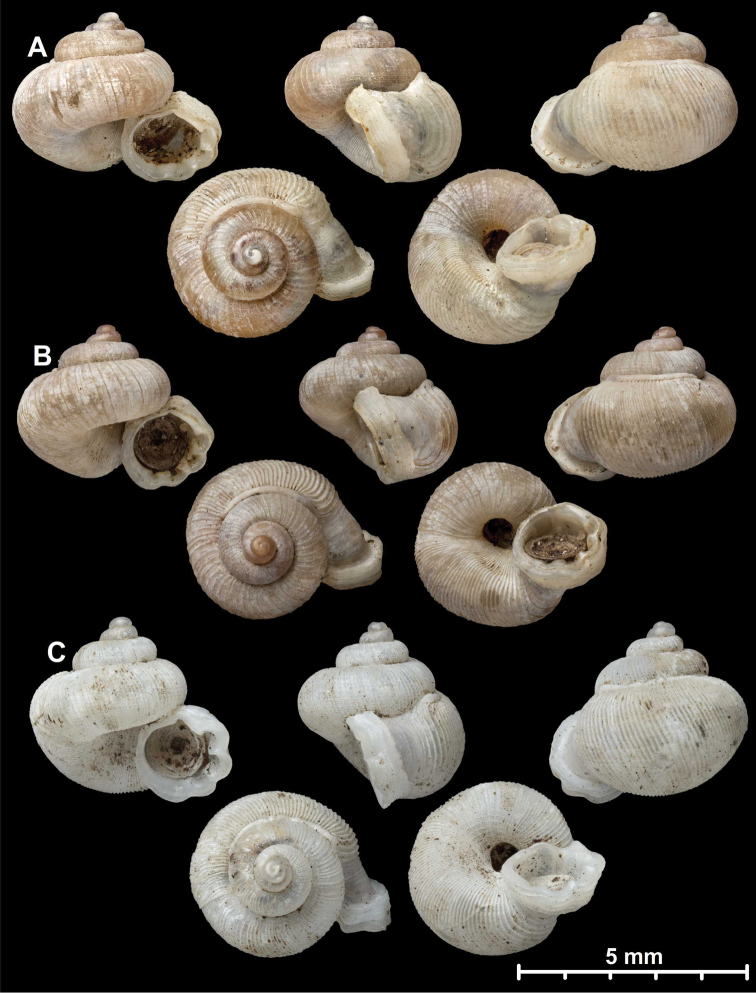
Shells of Metalycaeus
brahma (Godwin-Austen, 1886) A syntype of A.
brahma (NHMUK 1903.7.1.2610) B syntype of A.
commutatus Godwin-Austen, 1914 (NHMUK 1912.4.16.293) C syntype of A.
chanjukensis Godwin-Austen, 1914 (NHMUK 1903.7.1.3583). All photographs: Kevin Webb (NHM).